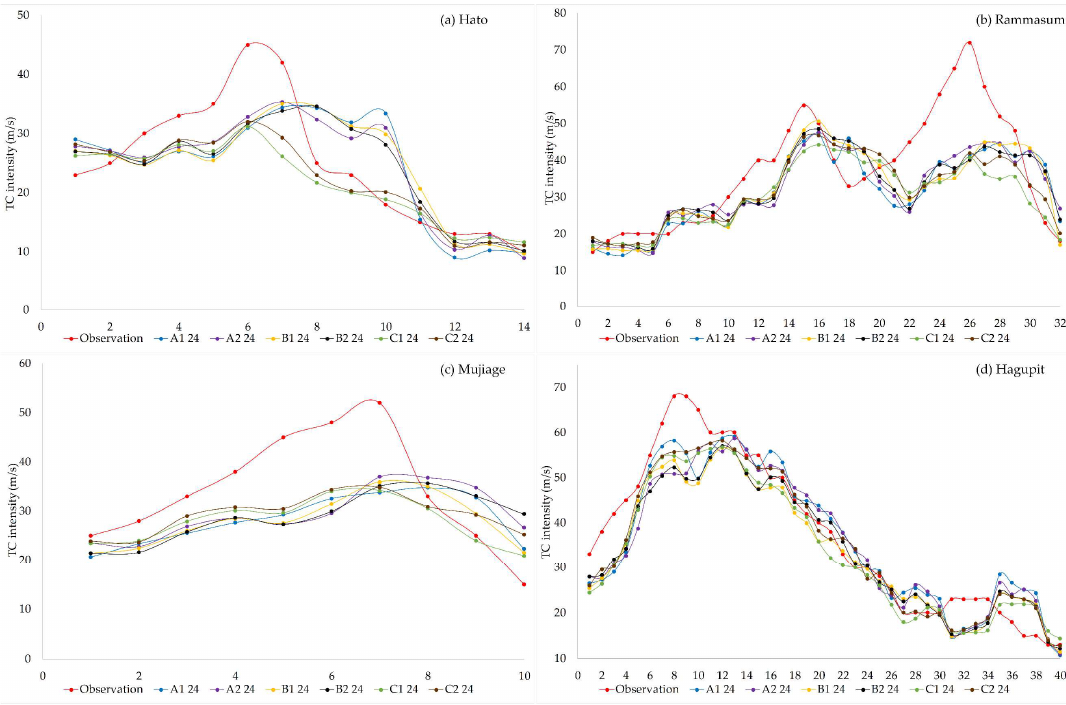
Figure 7. Observed and predicted sequence values of TC intensity with 24 h lead time for ( a ) Hato, ( b ) Rammasum, ( c ) Mujiage, and ( d ) Hagupit, respectively. The following color coding is used: red (observation), blue (A1, 24 h lead time), purple (A2, 24 h lead time), orange (B1, 24 h lead time), black (B2, 24 h lead time), green (C1, 24 h lead time), and brown (C2, 24 h lead time).